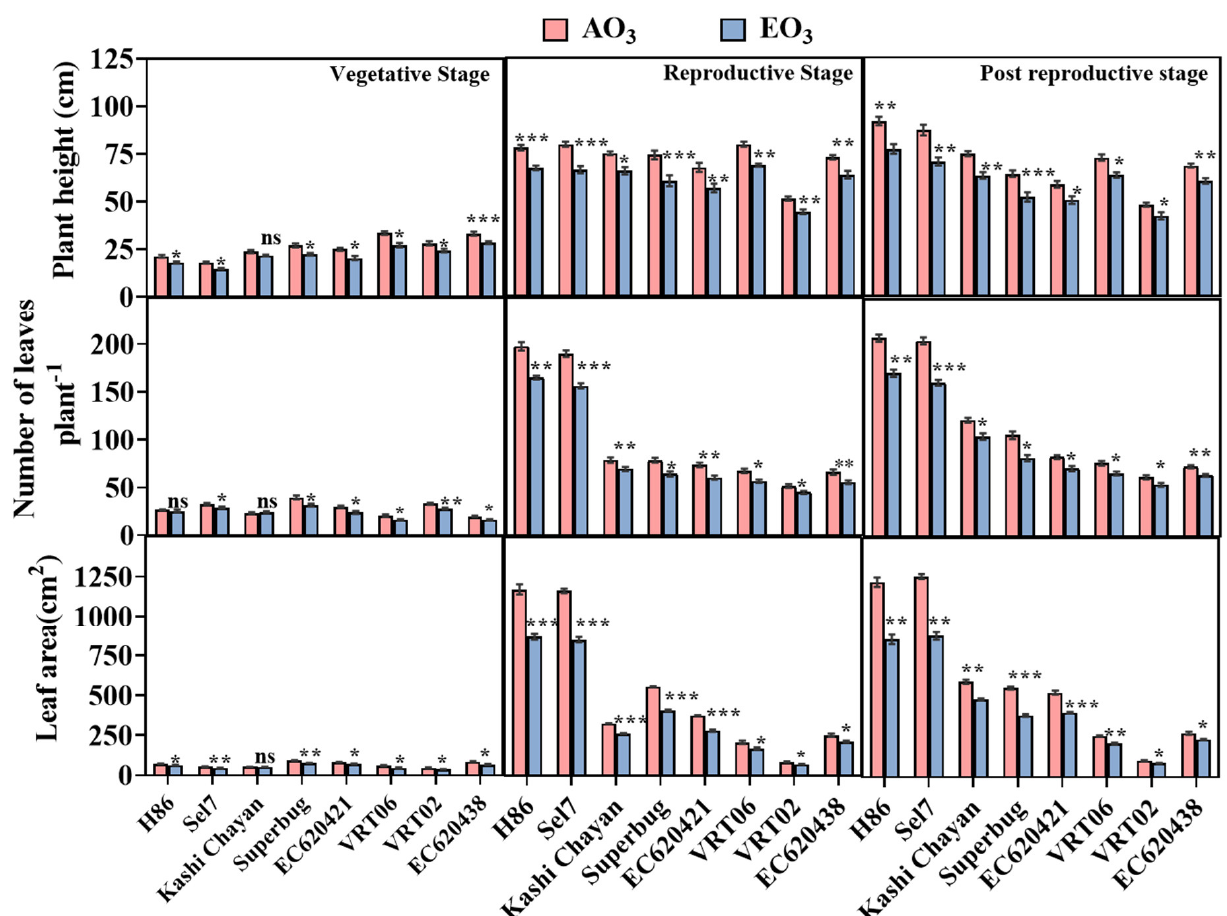
Figure 3. Variations in growth parameters (plant height, number of leaves and leaf area) of tomato cultivars under ambient and elevated O 3 treatments at different growth stages. Values are mean ± SE. Level of significance between AO 3 and EO 3 based on t -test; * p ≤ 0.05; ** p ≤ 0.01; *** p ≤ 0.001, ns not significant.